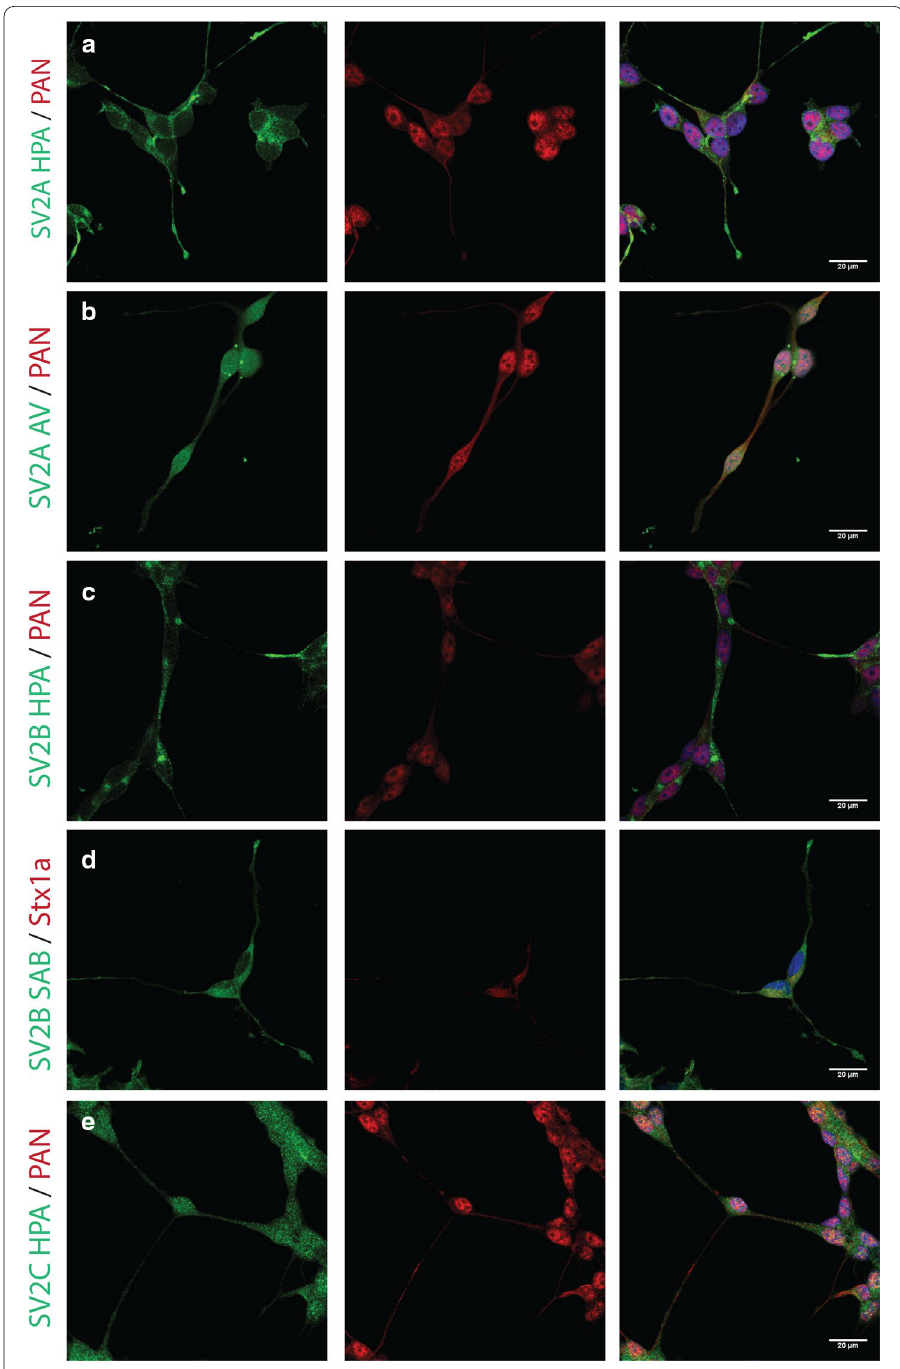
Fig. 1 Immunocytochemistry of SiMa SV2 proteins. SV2 isoforms were stained in green, Pan neuronal cocktail in red, nuclear staining using DAPI depicted in blue. Images acquired using confocal microscopy, merged images of three stacks. Scale bar 20 µm. Several antibodies were used for the SiMA cell lines. a , b SiMa cells stained for SV2A (green) using two different antibodies and neuronal marked (red) reveal punctuate SV2A staining in processes and around soma. c , d SiMa cells stained for SV2B (green) using two different antibodies and neuronal marker (red) or Stx1a (red) reveal moderate staining in projections. e SiMa cells stained for SV2C (green) and neuronal marked (red) reveal staining in the cell